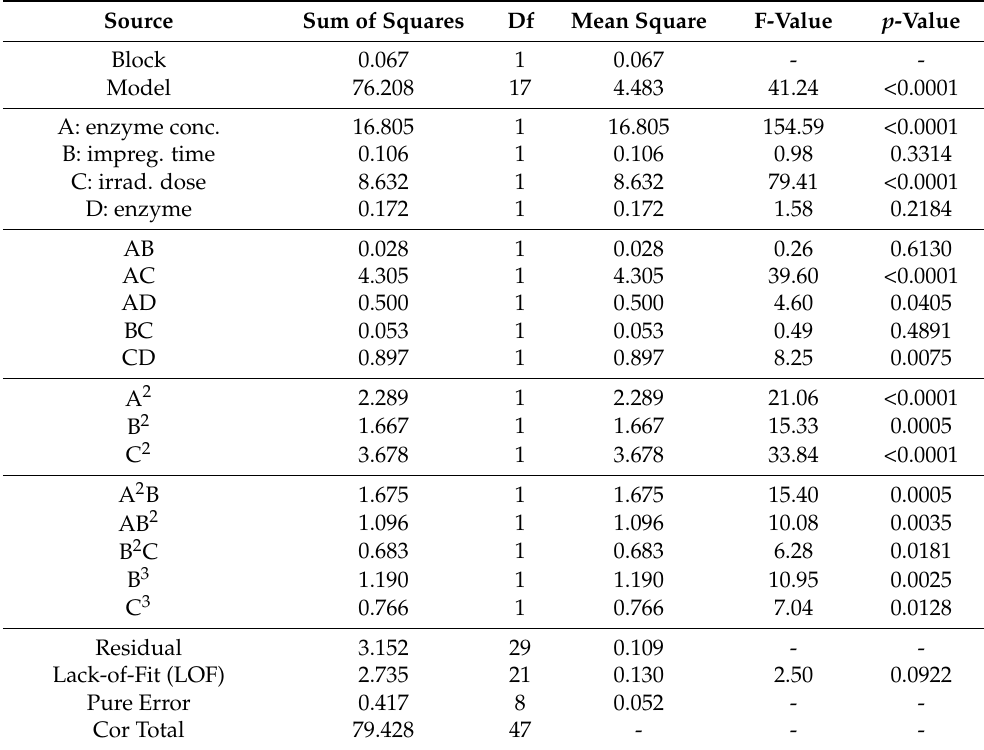
Table 2. ANOVA results of I-optimal design for V max (transformed with ln